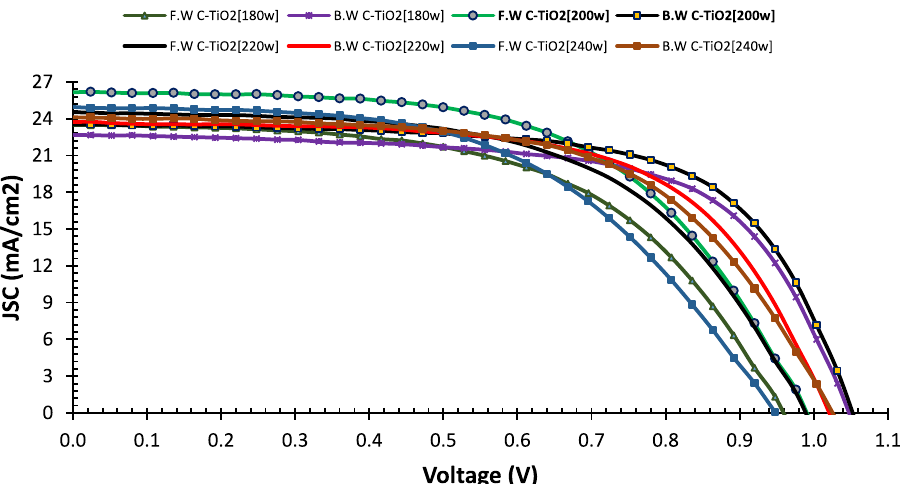
Fig. 5. J – V characteristic curves of the fabricated PvSC based on C-TiO 2 DC sputtered at 180, 200, 220, and 240 watts.